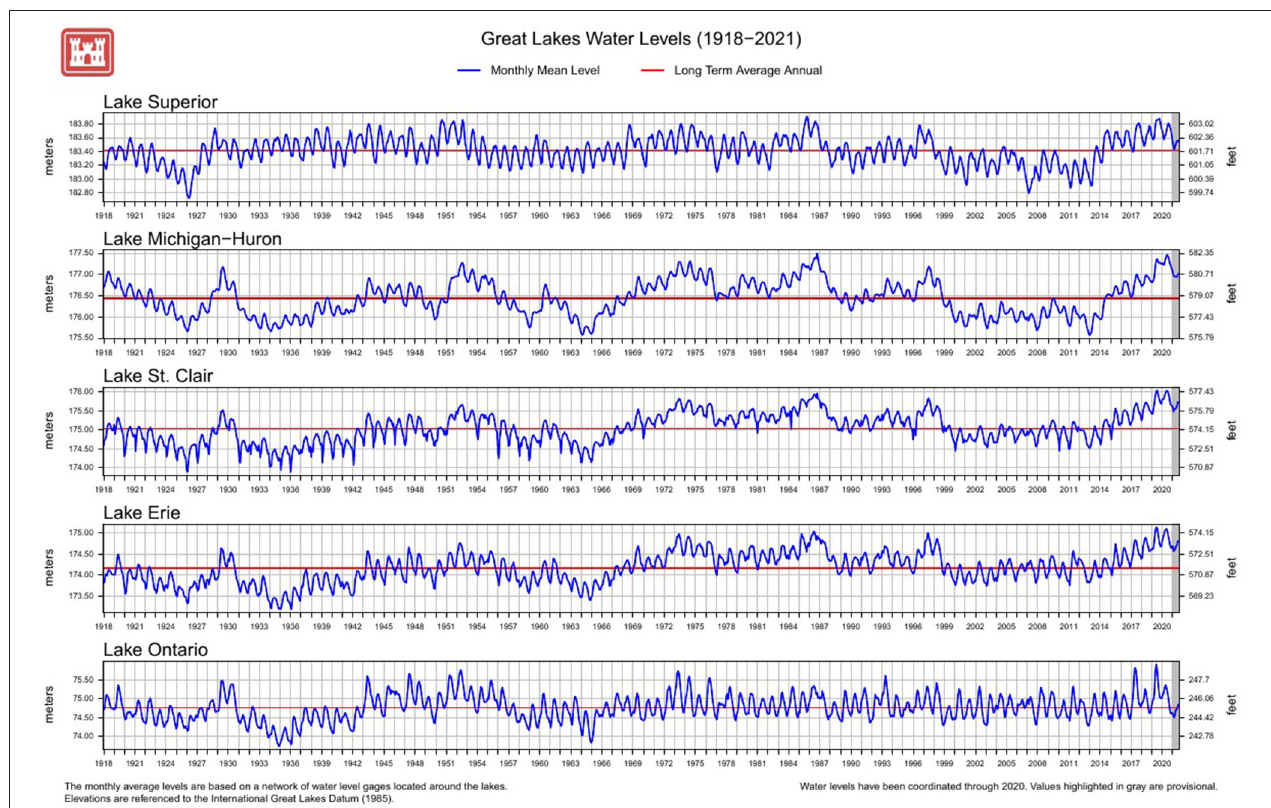
FIGURE 2 | Monthly mean water levels for each of the Great Lakes and Lake St. Clair shown as a blue line (as of September 2021). 2021 data highlighted in gray is still provisional (source: